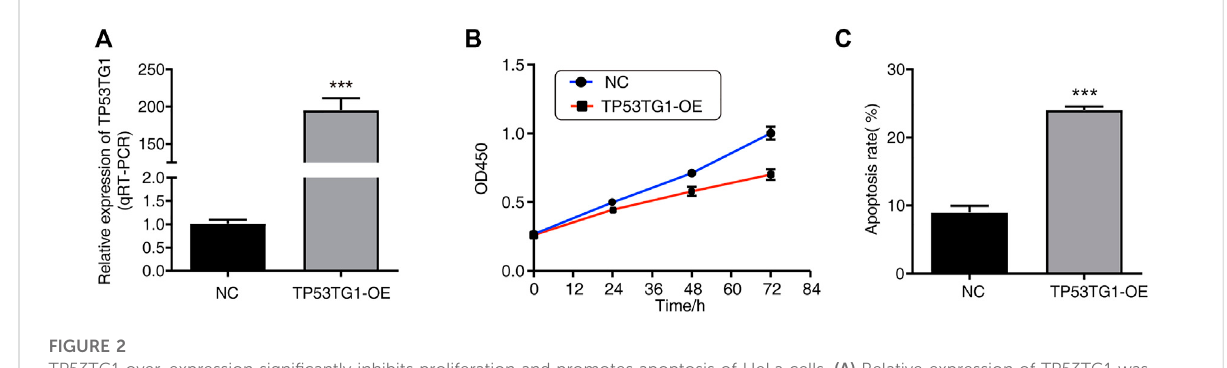
FIGURE 2 TP53TG1 over-expression signi fi cantly inhibits proliferation and promotes apoptosis of HeLa cells. (A) Relative expression of TP53TG1 was validated by RT-qPCR in HeLa cells after it was overexpressed. (B) The cell proliferation index was calculated according to the OD450 value. (C) Apoptosis of TP53TG1-overexpressing HeLa cells and controls was measured using fl ow